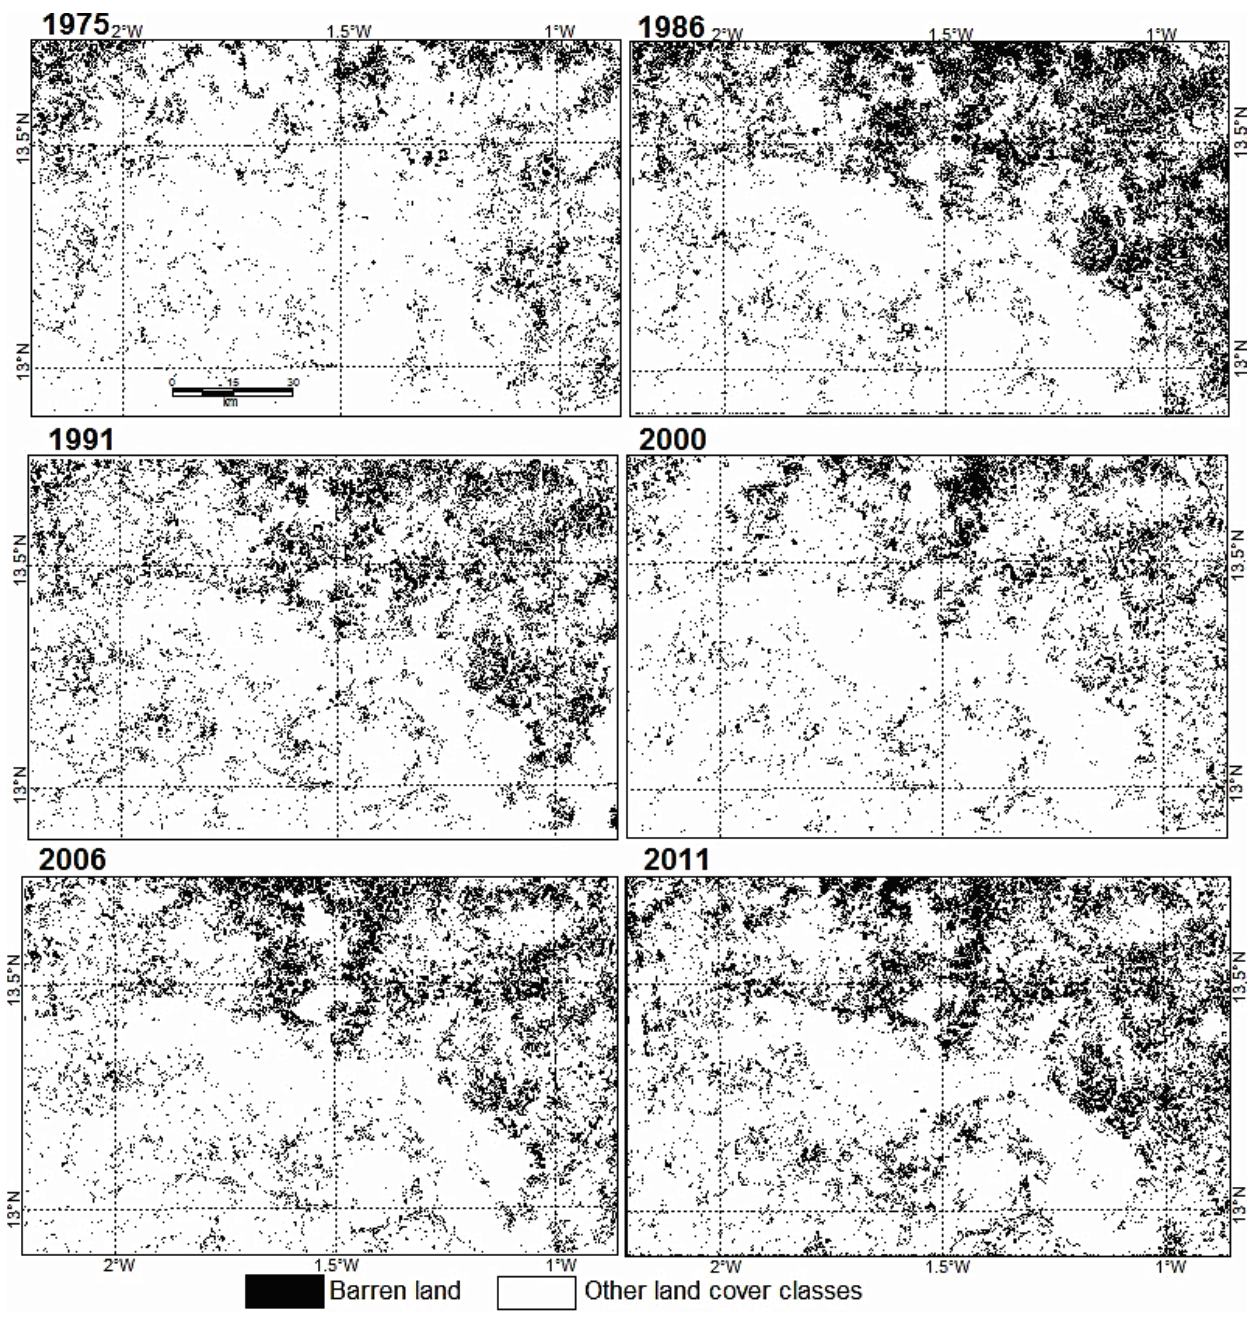
Figure 2. Pictorial representation of the evolution of the Barren Land in the study area from 1975 to